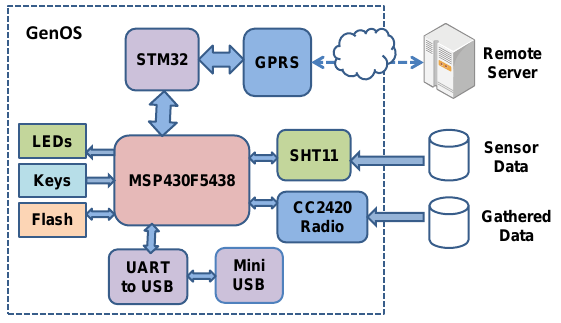
Figure 3: The structure of GenOS